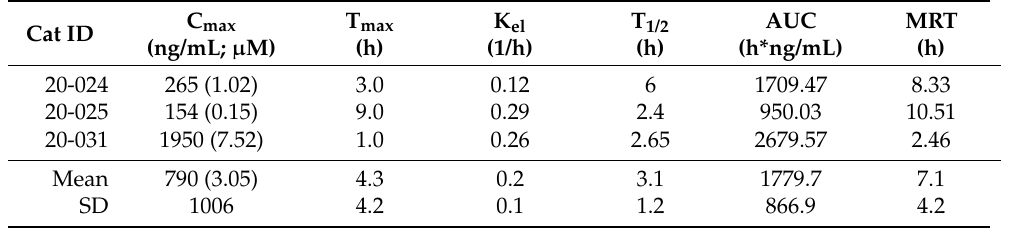
Table 2. Pharmacokinetic parameters for metabolite (NHC) from noncompartmental analysis follow- ing a single 10 mg/kg dose of molnupiravir in three